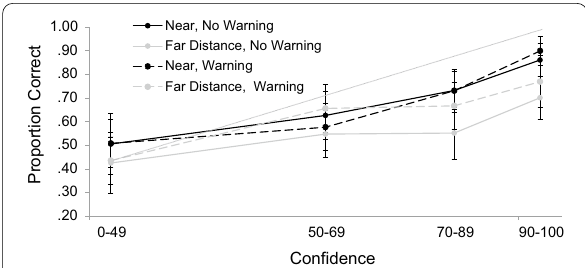
Fig. 5 Calibration Curves for Faces that were Presented at a Near or Simulated Far Distance and either Warned or Not Warned in Experiment 3. Note: The diagonal line indicates optimal calibration. Bars represent descriptive 95% confidence